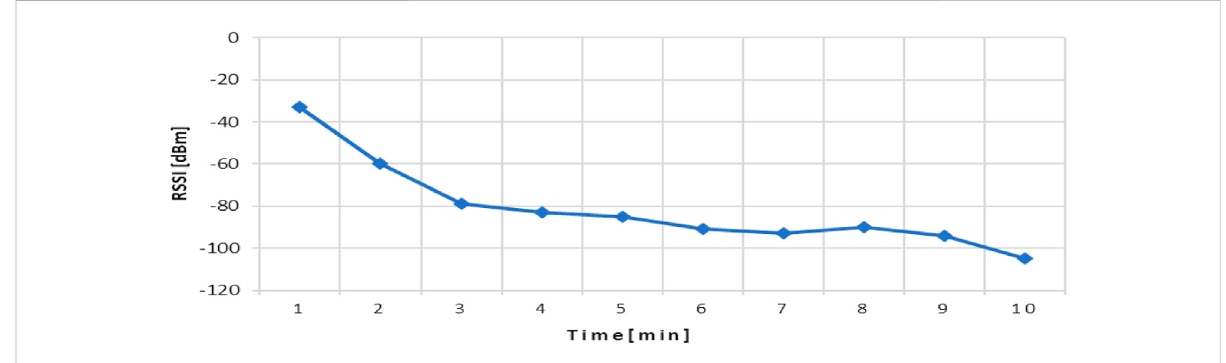
FIGURE 12 RSSI chart of the remote LoRa module.